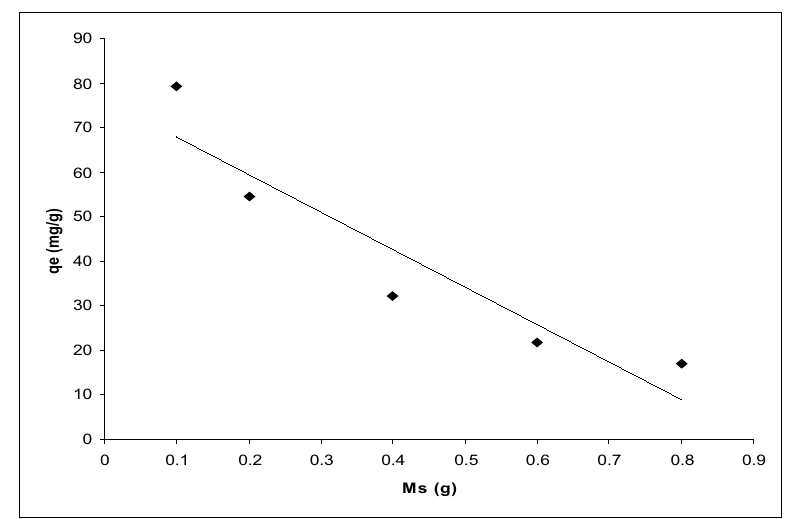
(mg g -1 ) against m (g) for the sorption of CR by PKC. e s